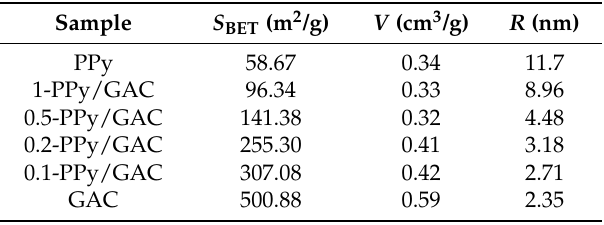
Table 2. The textural properties of the adsorbents.